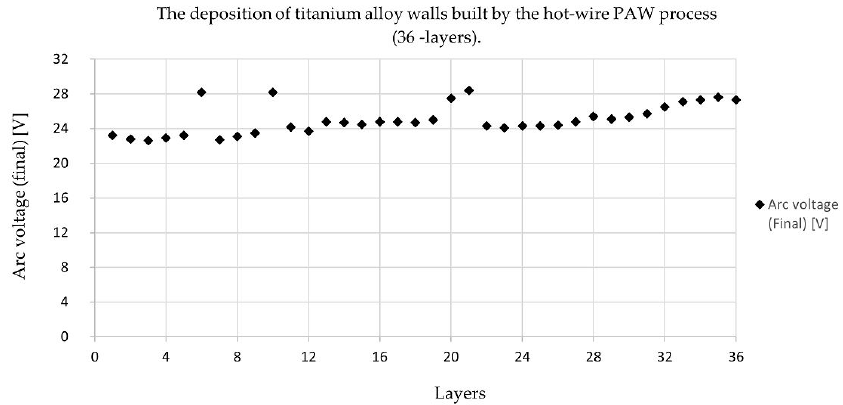
Figure 9. Arc voltage (final) values of the deposition of the hot-wire PAW process per layer.